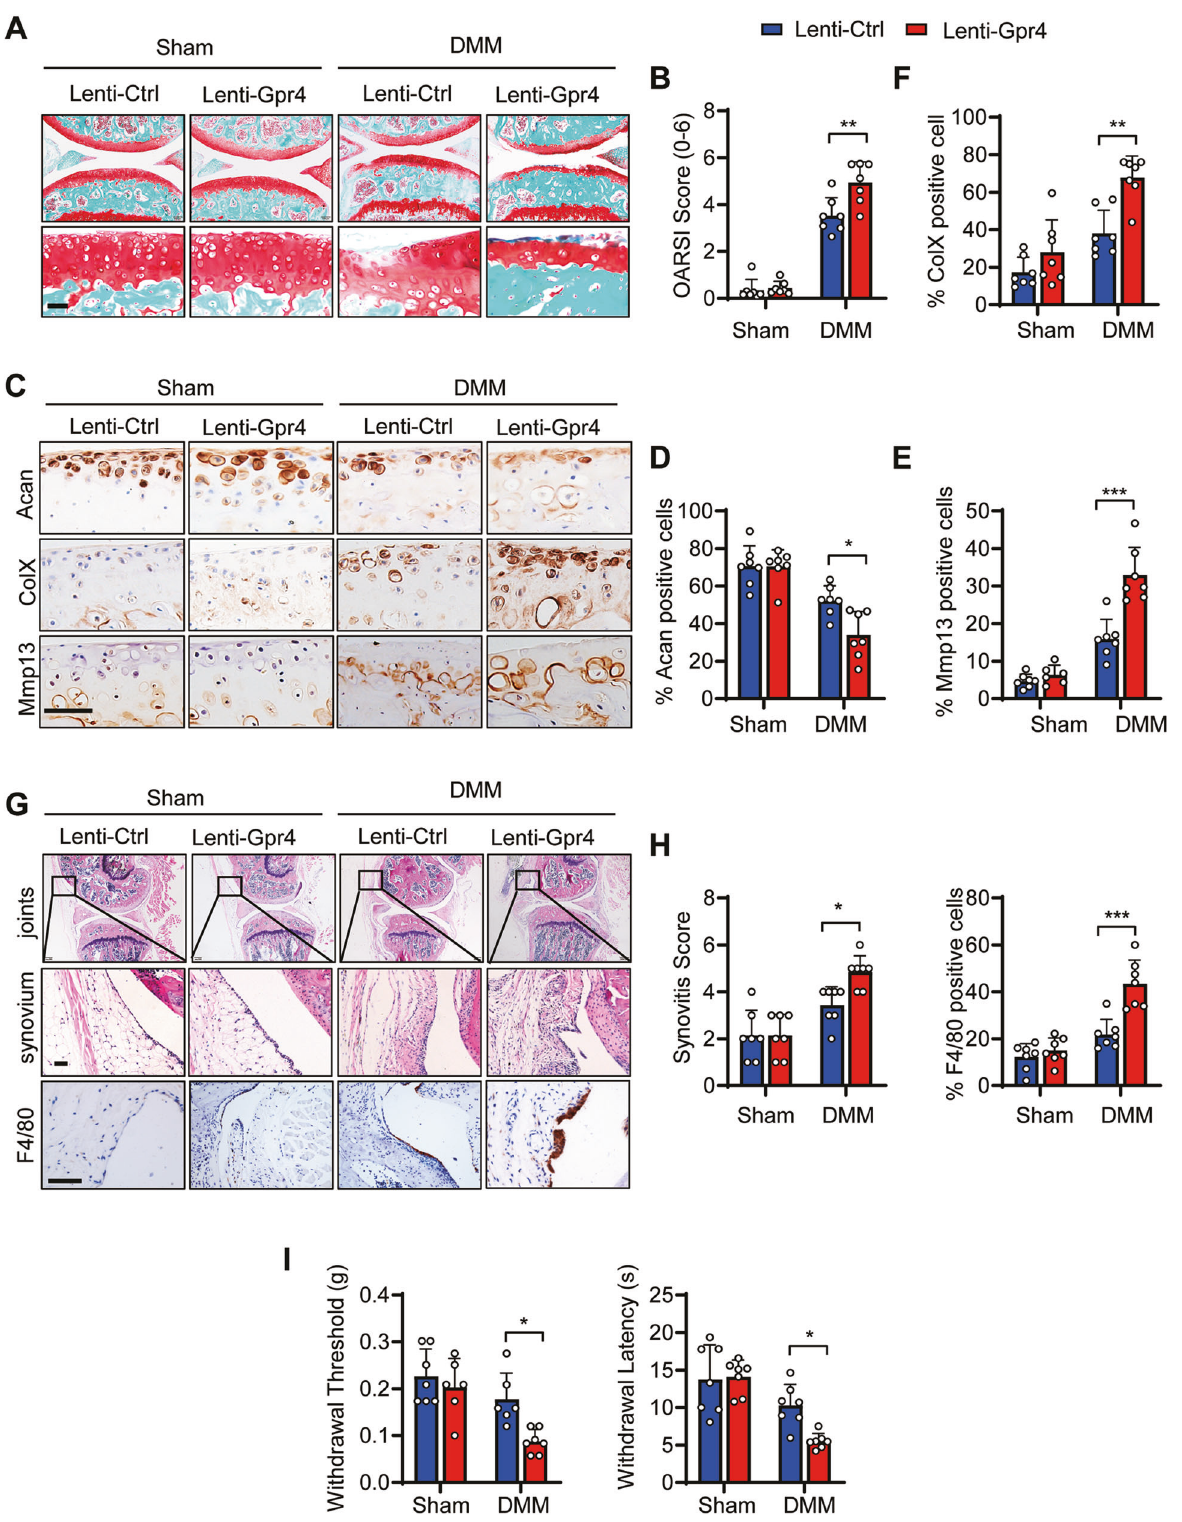
overexpression signi fi cantly aggravated DMM surgery-induced